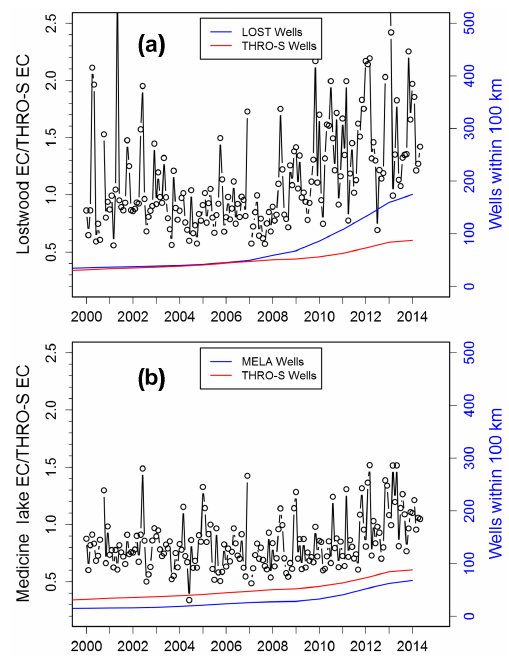
Figure 15. Timeline of ratios of EC concentration at (a) LOST, and (b) MELA, relative to THRO-S. Also shown are data representing wells within 100km of the given site, weighted by distance, and wells within 100km of THRO-S. EC data are shown as monthly averages, while data for well counts are annual averages to better account for the uncertainty in the dates when wells began